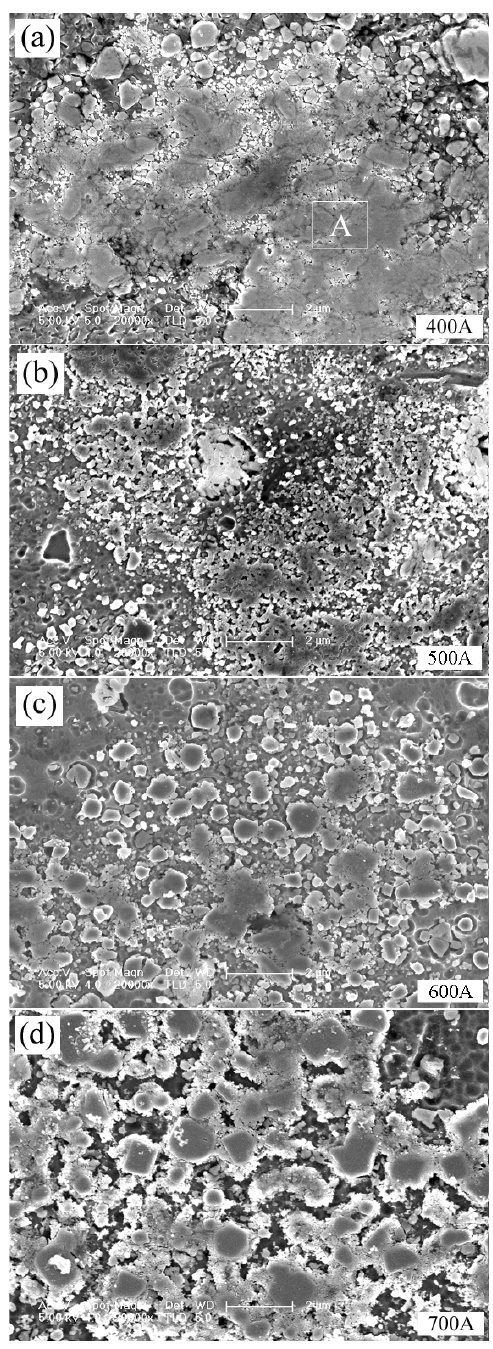
Figure 9: Effect of melting current on the microstructures of TiB 2 /Al